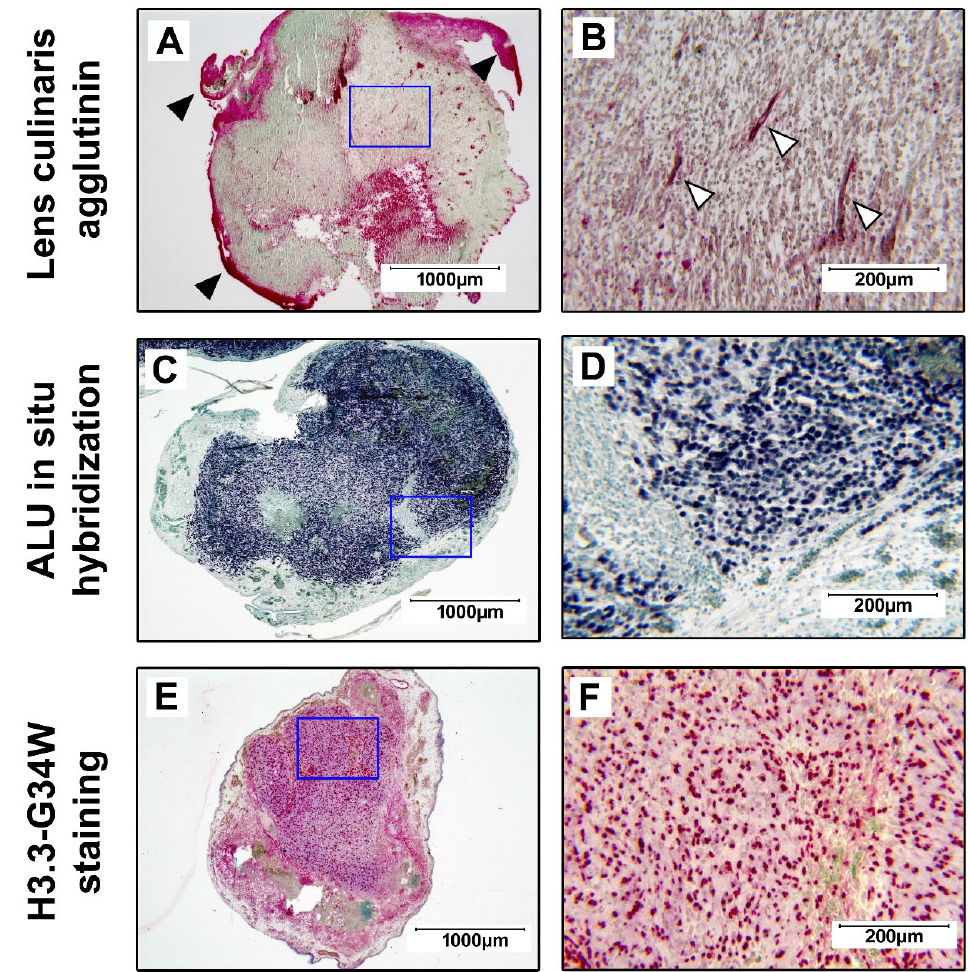
Figure 2. Detection of human H3.3-G34W-positive stromal cells in tumor xenografts. The resected tumor tissue was fixed in 4% paraformaldehyde, embedded in paraffin, sectioned, and stained. ( A , B ) Lens culinaris agglutinin staining showing the red stained CAM ( ▶(cid:4667) and blood vessels ( ▷(cid:4667) within the unstained tumor tissue. ( C , D ) Hybridization of the xenograft with a probe specific for the human ALU DNA sequence (dark blue). ( E , F ) H3.3-G34W expression in GCTB stromal cells (red). The blue frames define the inserts shown at a higher magnification on the right. All samples were counterstained with methyl green.